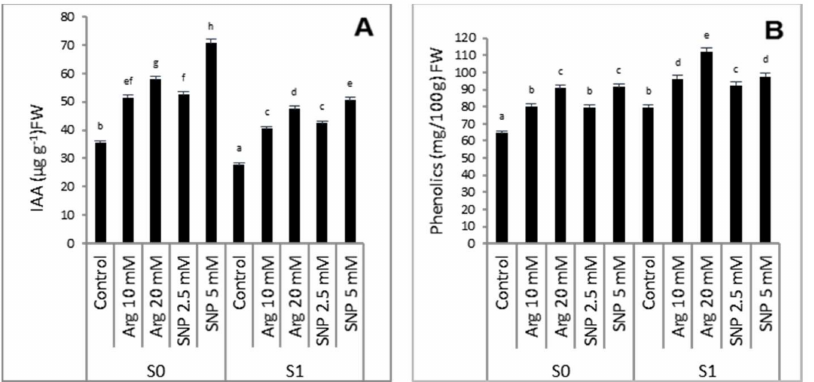
Figure 2. Effect of arginine or SNP on indole acetic acid content ( A ) and phenolic compounds ( B ) of wheat plant under salinity stress. S 0 = 1.2 mM NaCl, S 1 = 85.5 mM NaCl. All the statistical differences were presented relative to the untreated control. Data are means of three replicates ± SE; means with different letters are significantly different ( p ≤ 0.05).